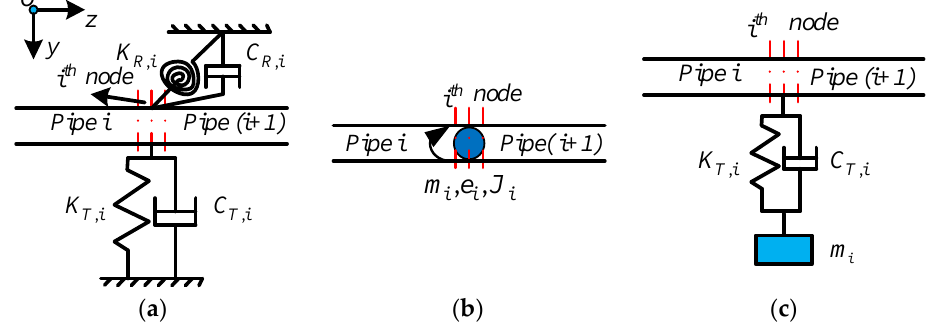
Figure A1. The simplified models for the accessories: ( a ) The physical model for the clamps and complex constraint; ( b ) the physical model for the valves and flanges; ( c ) the physical model for the vibration